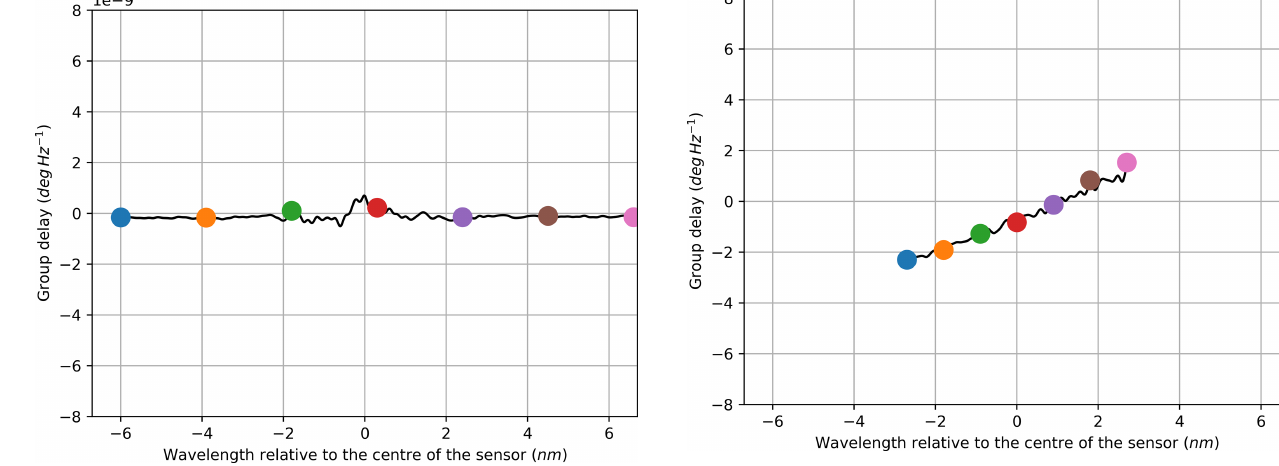
Figure 13. Group delay derived from the electrical phase of a cFBG in transmission configuration.